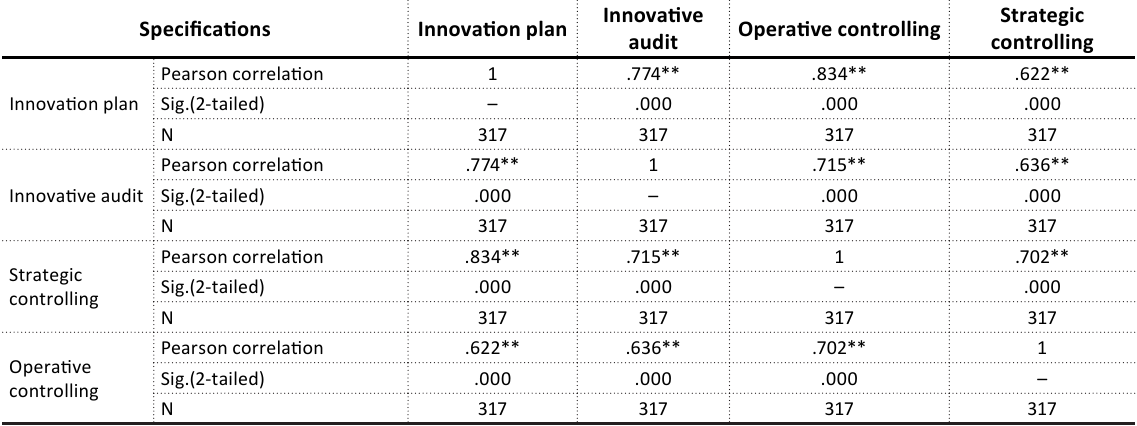
Source: Processed by authors using